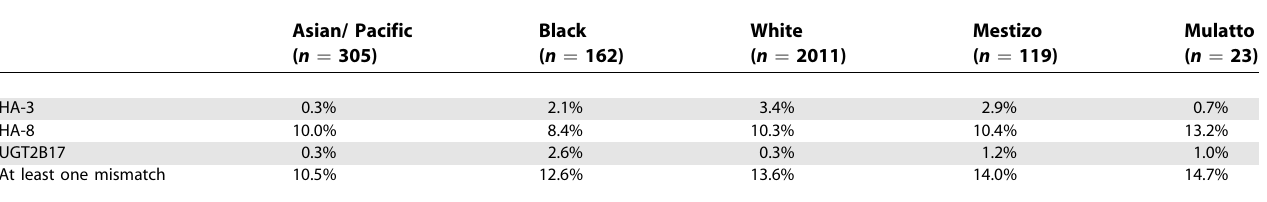
Table 8. Estimated Disparity Rates for Broadly Expressed Minor H Antigens in MUD Transplant Sib Pairs Corrected for the Frequencies of the HLA Restriction